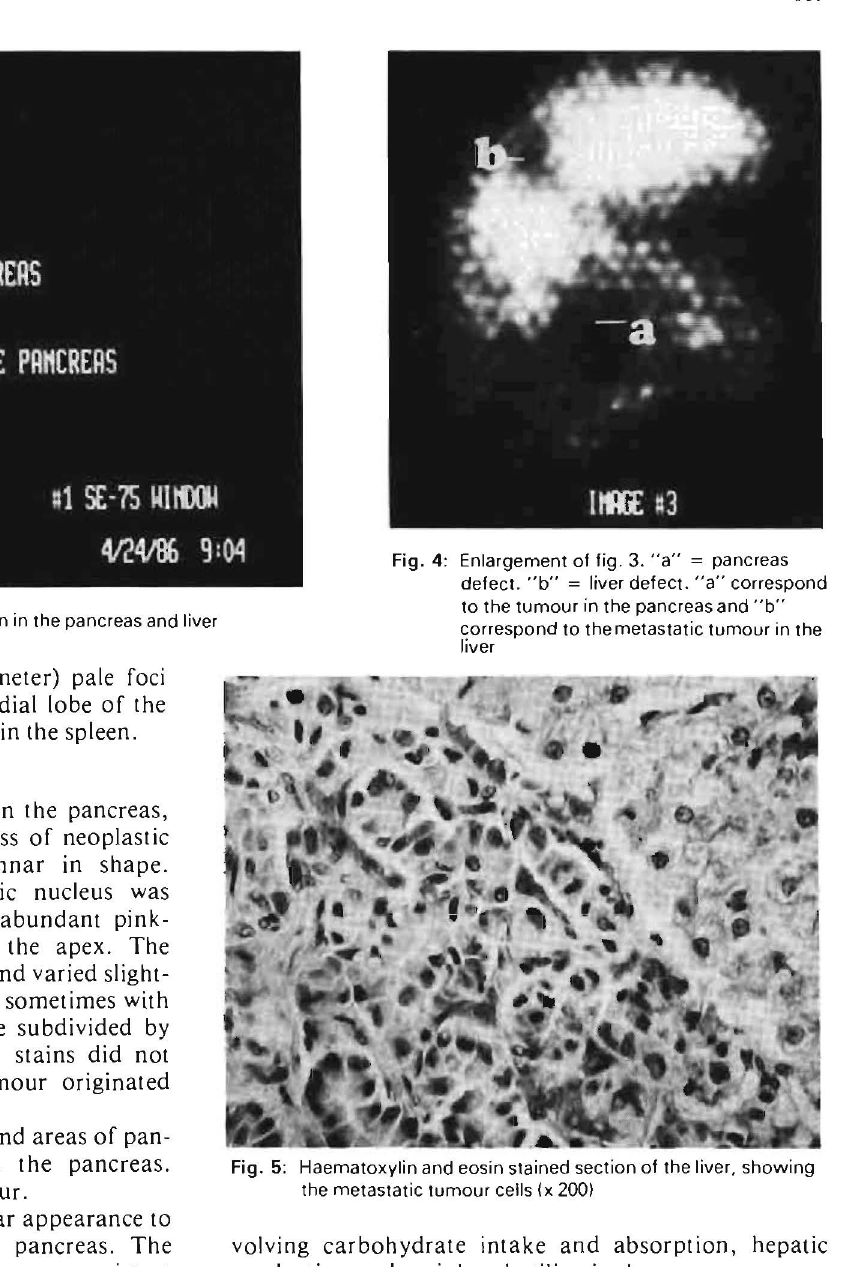
cells that were predominently columnar in shape.